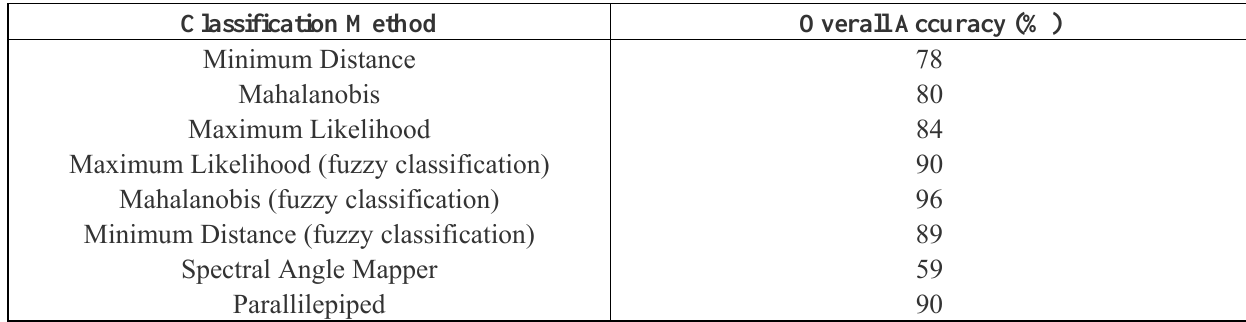
Table 2. Accuracy of each image classification method.